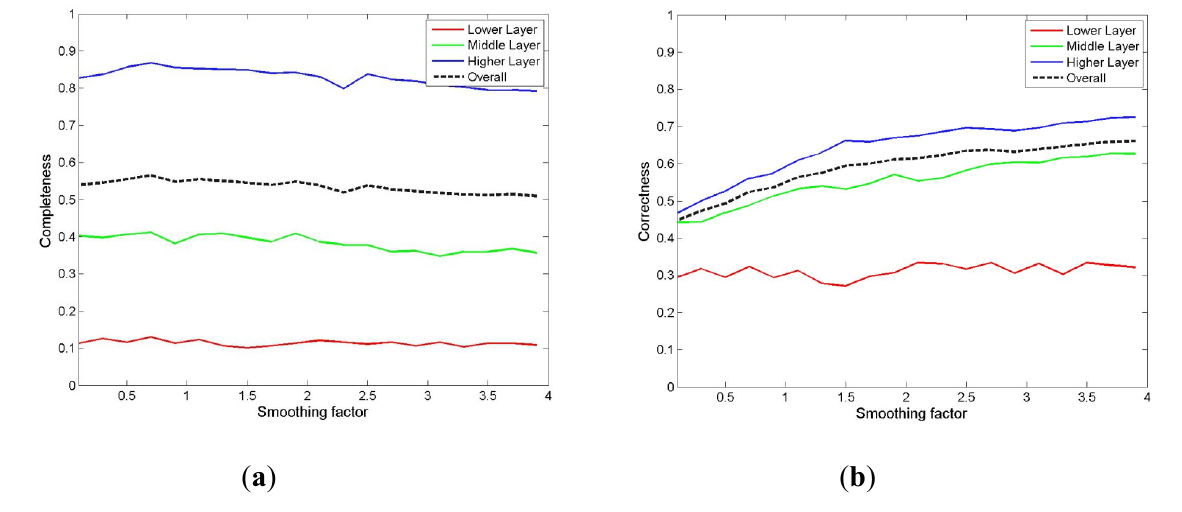
Figure 5. Sensitivity analysis with respect to the parameter λ for the dataset of Test Site I acquired under leaf-off condition; ( a ) Completeness; ( b ) Correctness; colored lines indicate the forest layers.